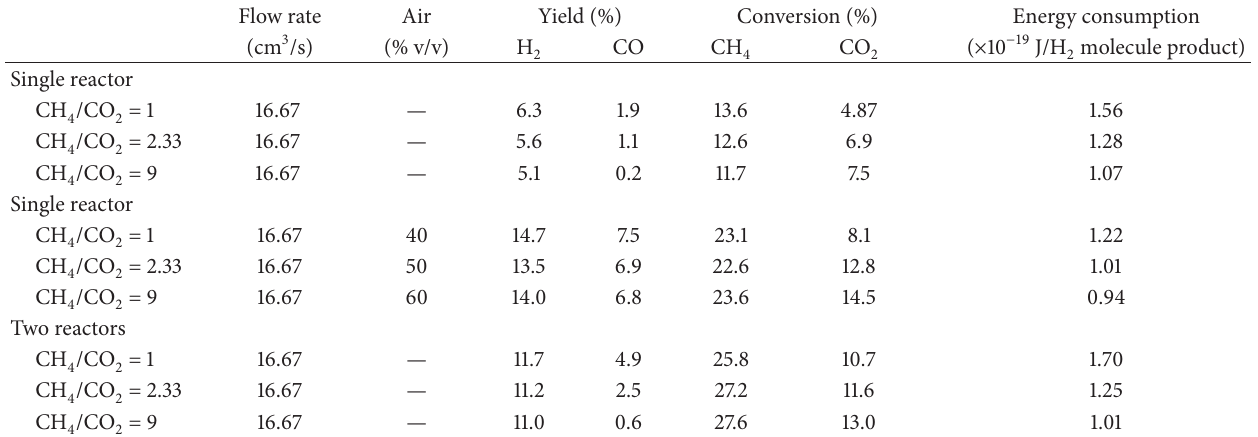
Table 1: Performance of plasma assisted reforming of